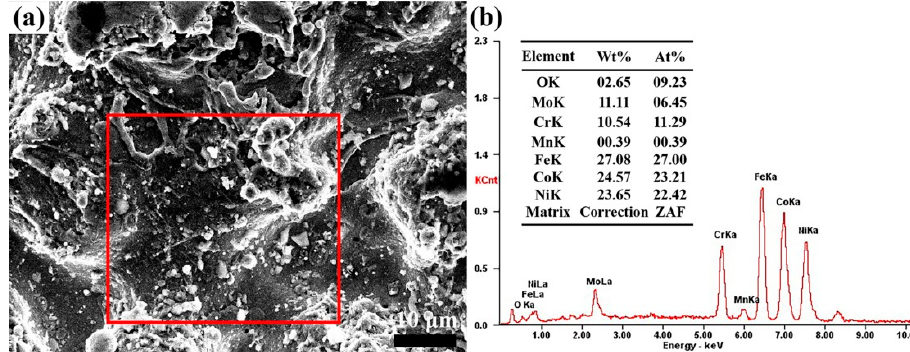
Figure 4. Elemental analysis results of plasma sprayed FeCoNiCrMo 0.2 high entropy alloy coating on BS960 high strength steel surface. ( a ) is surface morphology, ( b ) is element content. Red square is tested area.